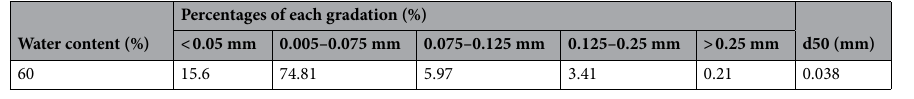
Table 1. The gradation rate in the experiment 1